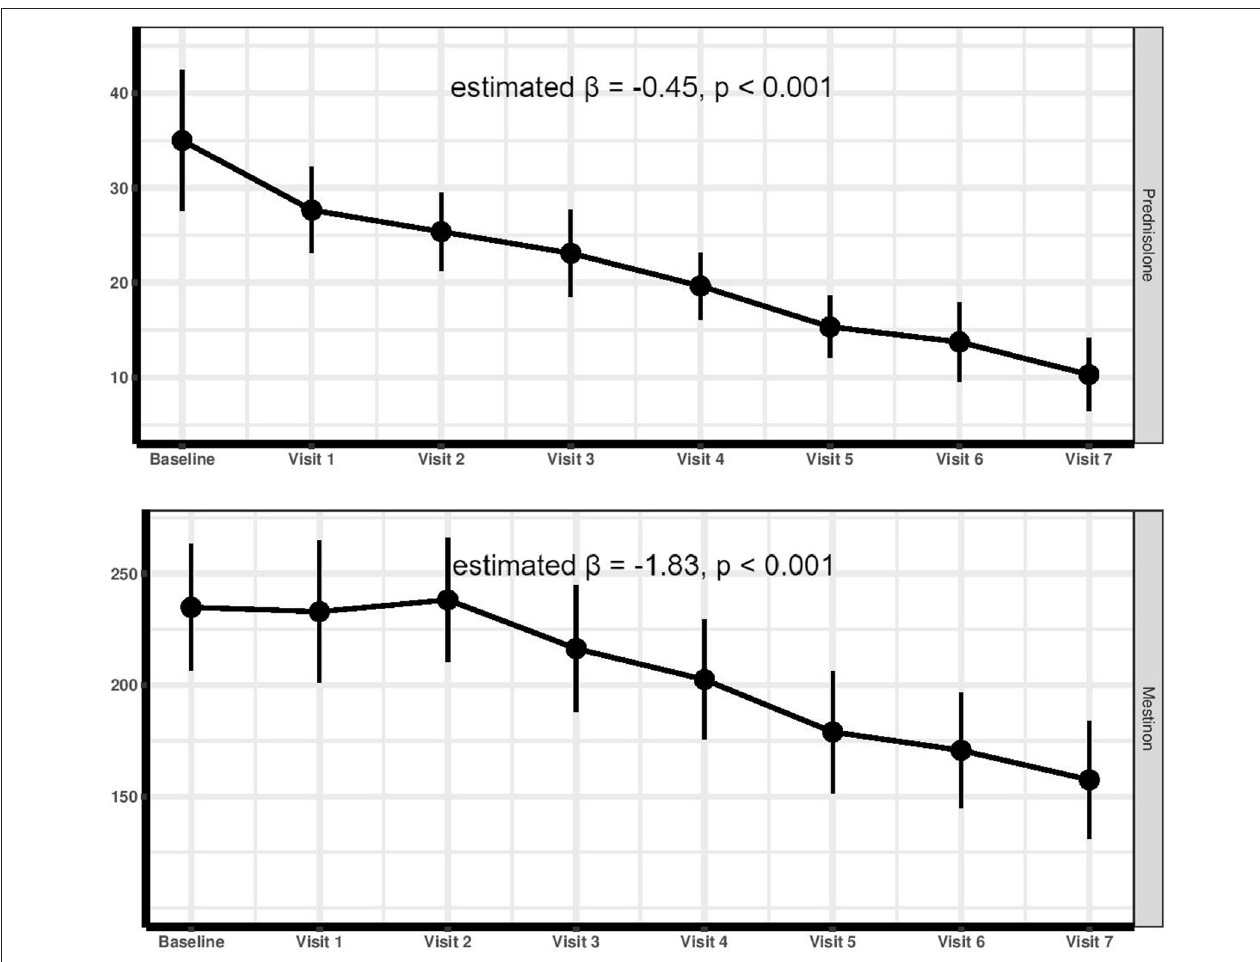
FIGURE 4 | The alteration trend of prednisolone and pyridostigmine administration dose during the trial period.